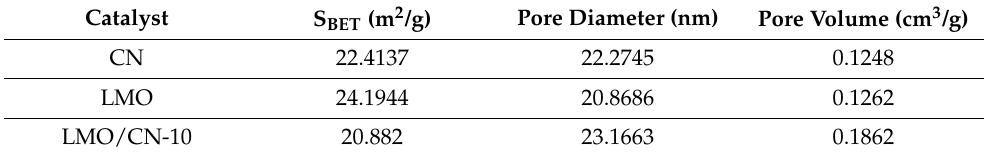
Figure 2. SEM images (Mag = 5.0 k × ) of CN ( a ), LMO ( b ), LMO/CN-10 ( c ), TEM images (Mag = 100,000 × ) of CN ( d ), LMO ( e ), LMO/CN-10 ( f ), EDS image of LMO/CN-10 ( g ) and XRD pattern of all samples ( h ). Table 1. Specific surface area, pore sizes, and pore volumes of CN, LMO, and LMO/CN-10.